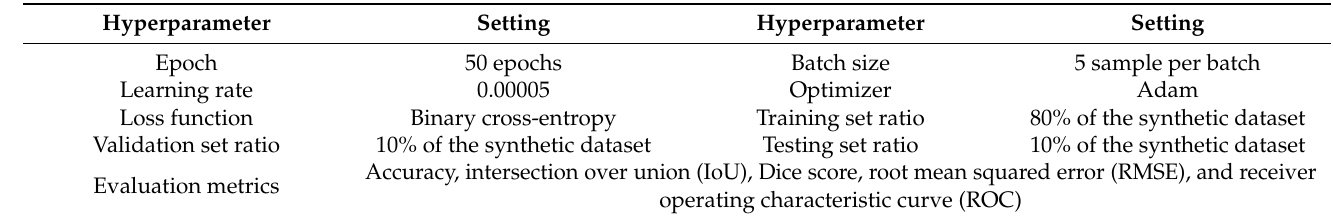
Table 3. The hyperparameters of the pre-training